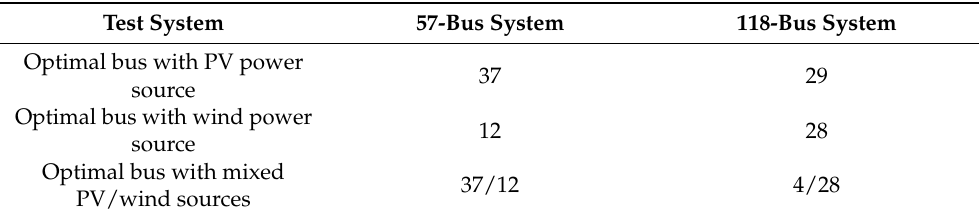
Table 4. Optimal buses designated for RESs connection in the studied systems.